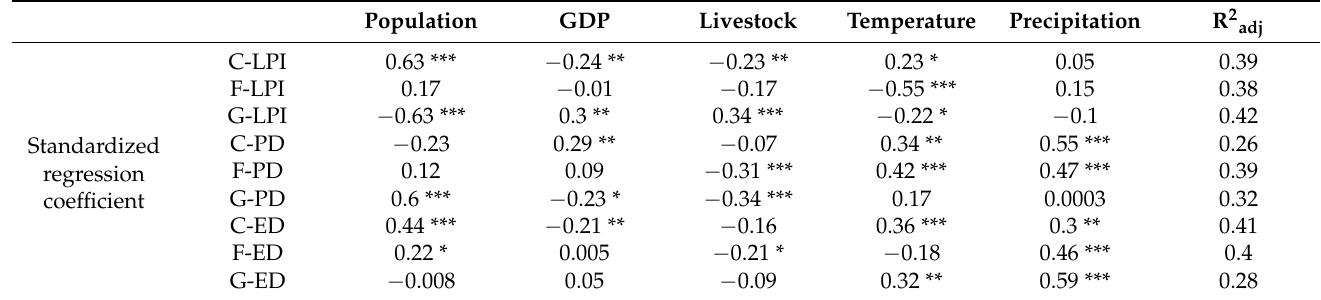
Figure 9. The spatiotemporal evolution of landscape metrics at the landscape level in Inner Mongolia from 2000 to 2015. Note: AI, aggregation index; CONTAG, contagion; LSI, landscape shape index; SHDI, Shannon’s diversity index. Table 3. Relationships between landscape metrics at the class level and the driving